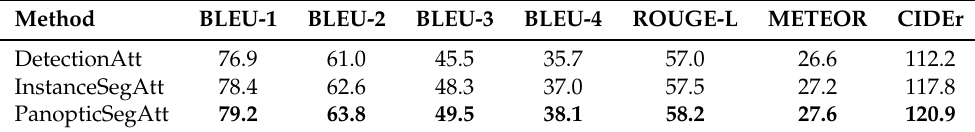
Table 3. The results obtained on the MSCOCO dense annotation test split. Higher is better in all columns. Scores are multiplied by a factor of